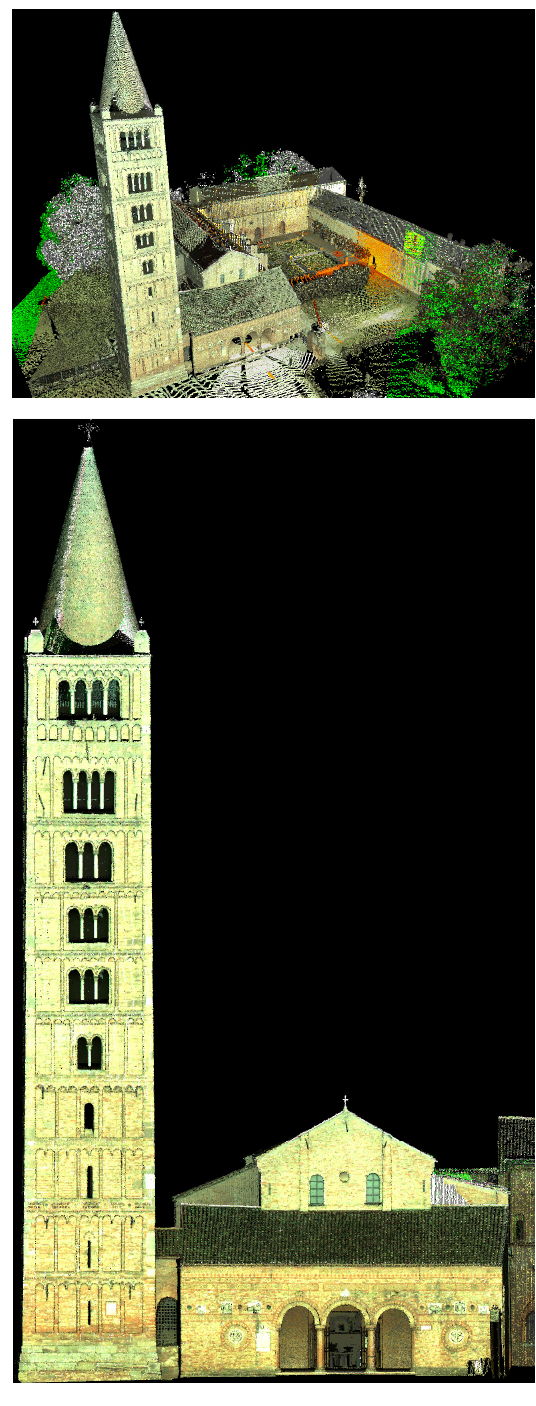
Figure 8. Final aligned point cloud obtained using a Leica ScanStation C10 laser